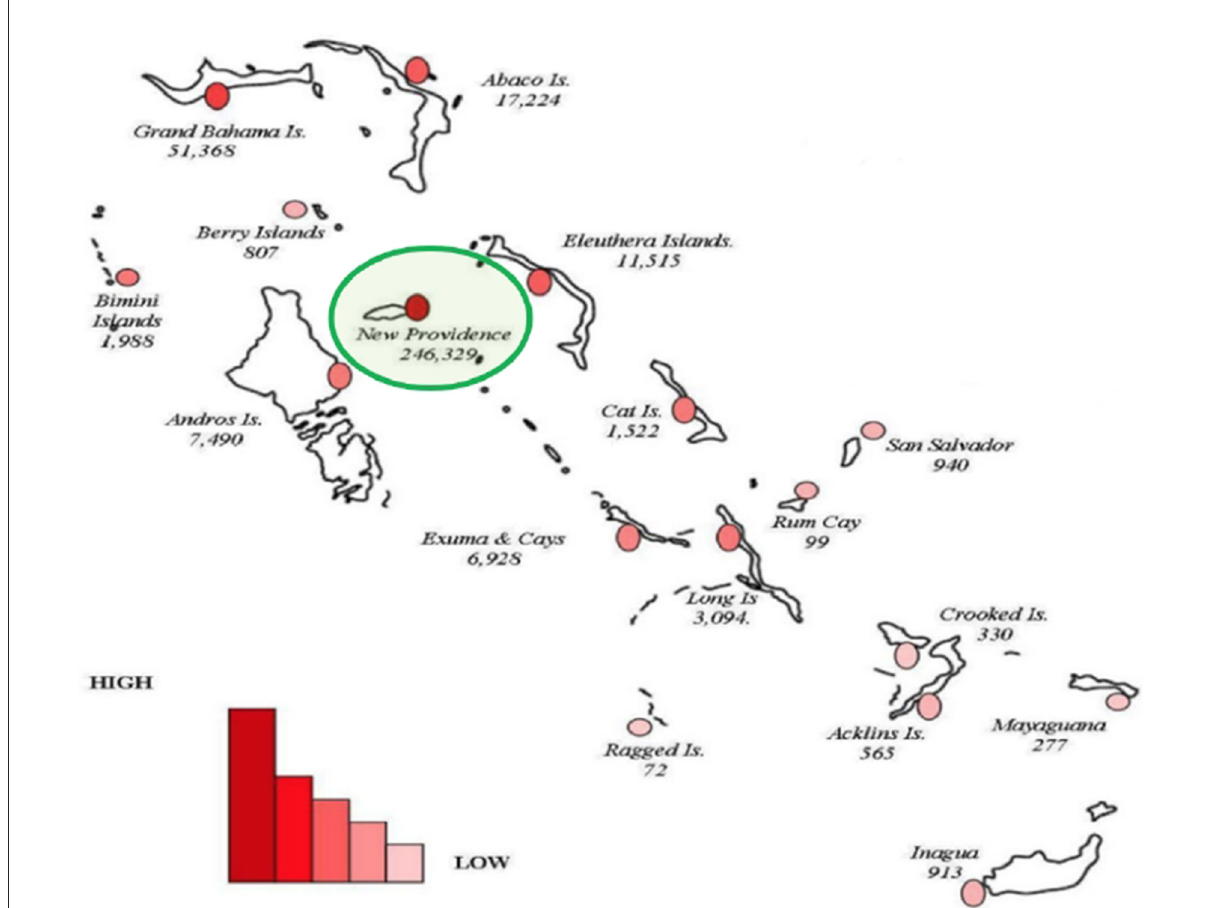
FIGURE2 Map of The Bahamas showing the geographical and population spread with the sizes of population for inhabited islands in 2010. Adapted from BDOS (32). The capital island (New Providence) has the highest population of residents of the country (see green